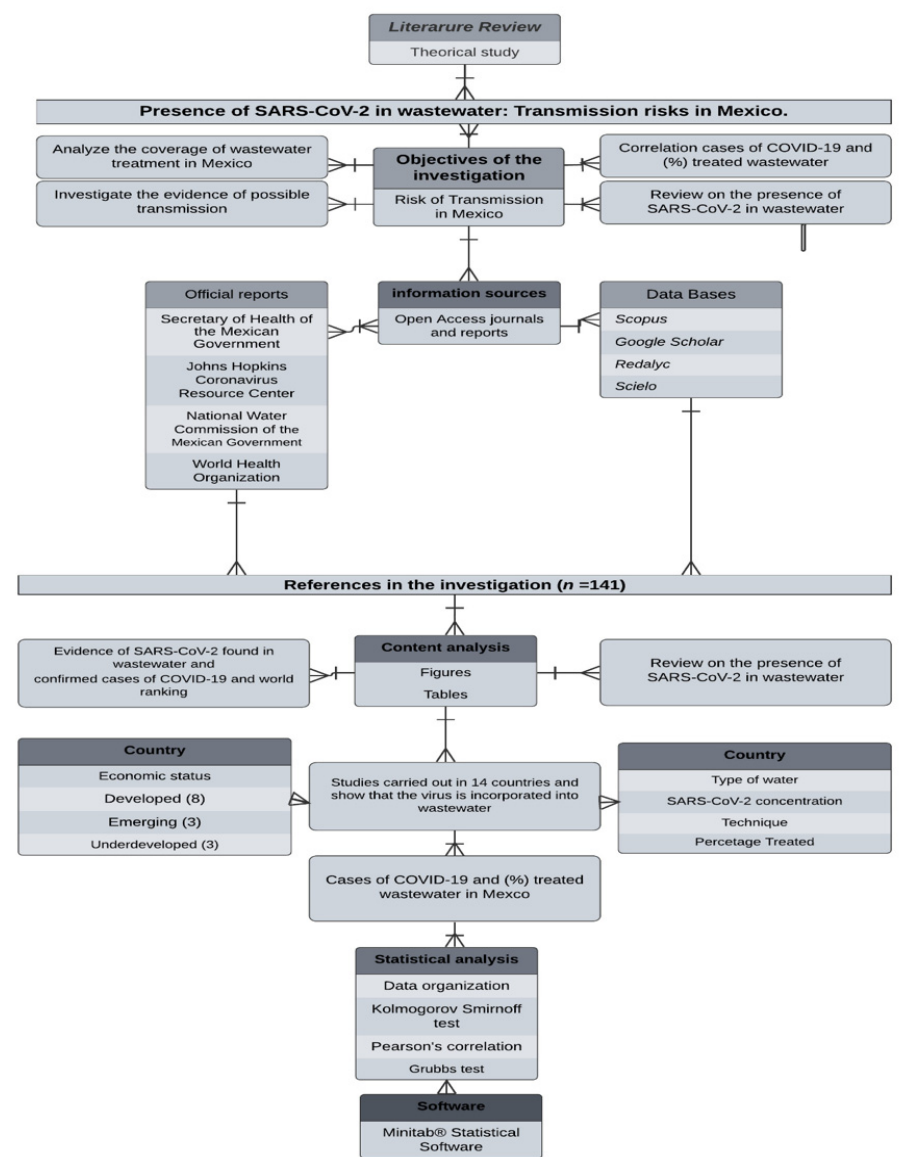
Figure 1. Flowchart of the methodology used in the research.